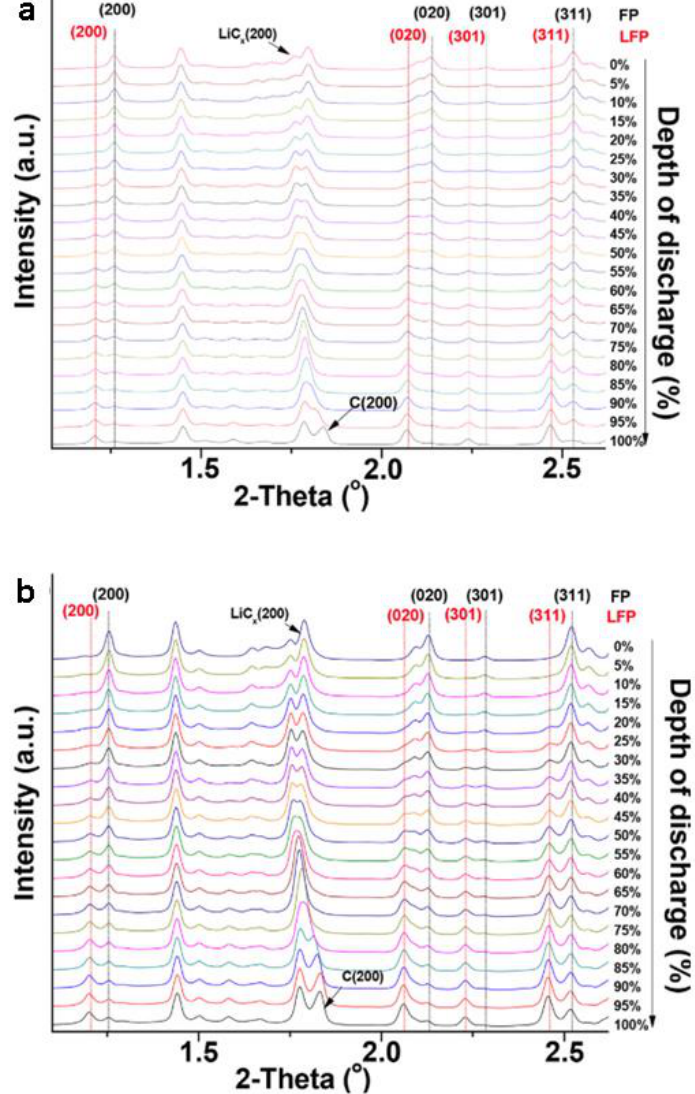
Figure 17. XRD patterns between 2θ = 1.0 and 2.8° from discharge at 1C rate as a function of DOD during the ( a ) 1st and ( b ) 2500th cycles [122]; with permission from ACS.